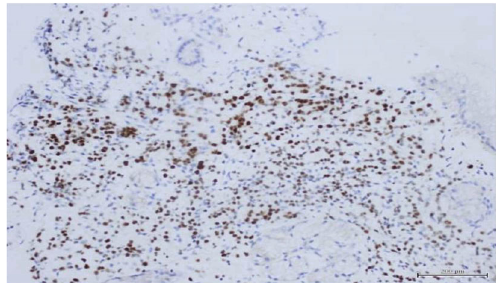
Figure 3: ER highlights the malignant cells, found in the gastric biopsy slides.